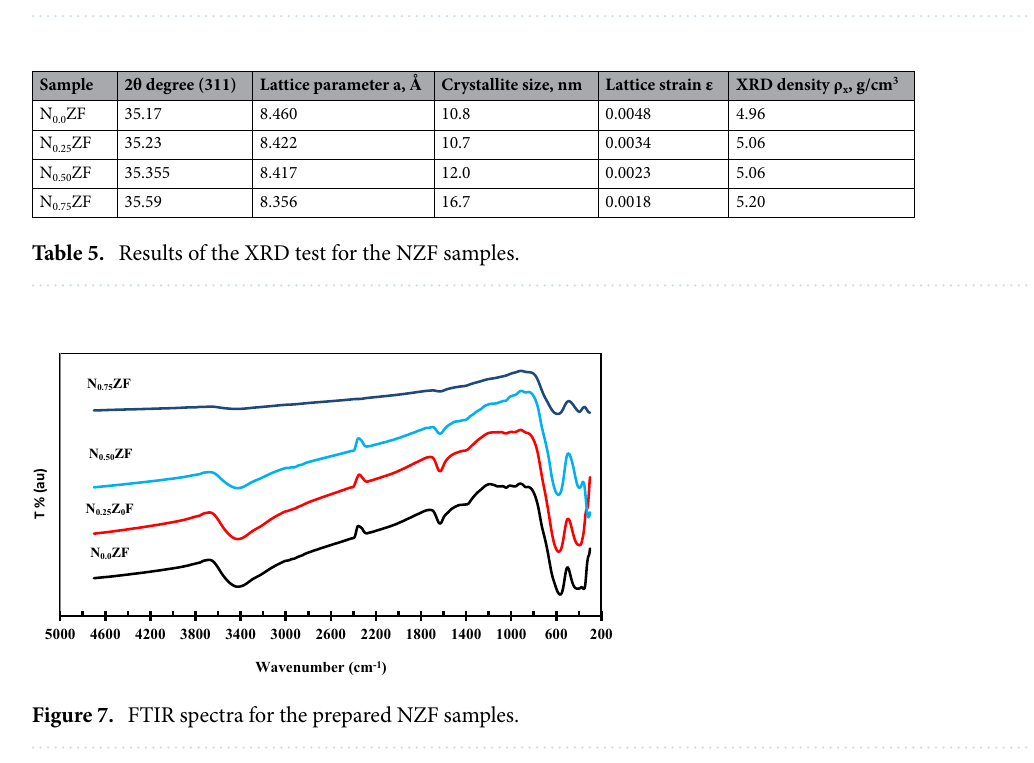
Figure 6. Plots of β hkl cosθ vs 4sinθ of NZF samples.